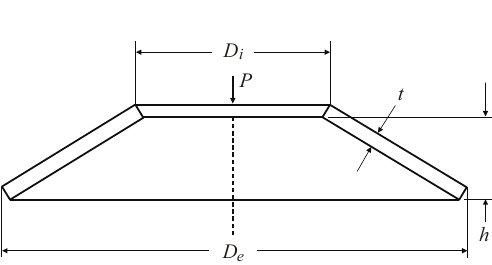
Figure 6. Configuration of a Belleville